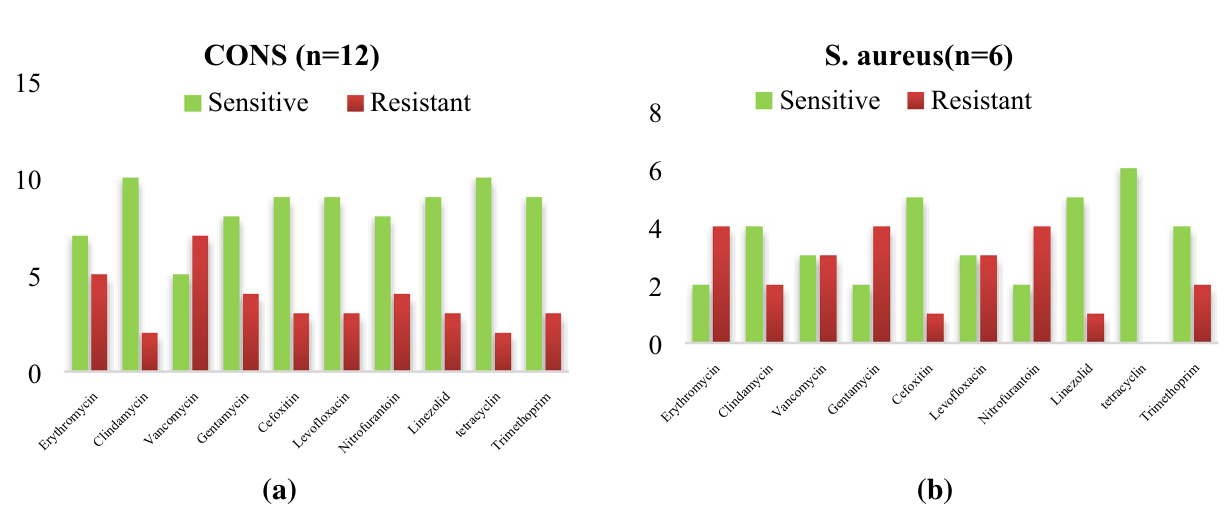
Figure 3. Antibiogram of CoNS and S. aureus isolated from the hands of health workers. ( a ) Antibiogram of CoNS isolated from hands of health care worker in PICU. ( b ) Antibiogram of S.aureus isolated from hands of health care worker in PICU. Out of 12 CoNS isolated, the highest sensitivity was observed for vancomycin (10/12), tetracycline (10/12), trimoxazole (9/12), while in S.aureus out of 6 isolates tetracycline (6/6) and linezolid (5/6) were the drugs sensitive to the